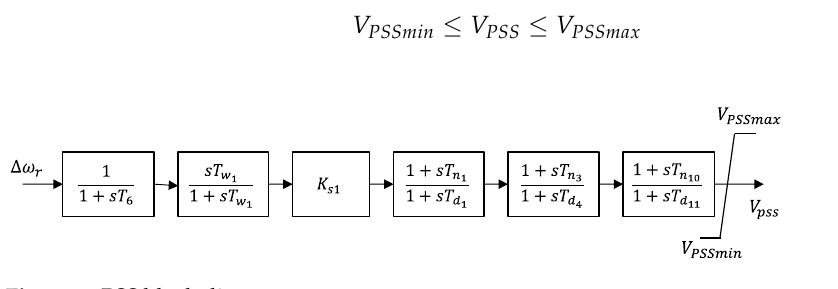
Figure 2. PSS block diagram.